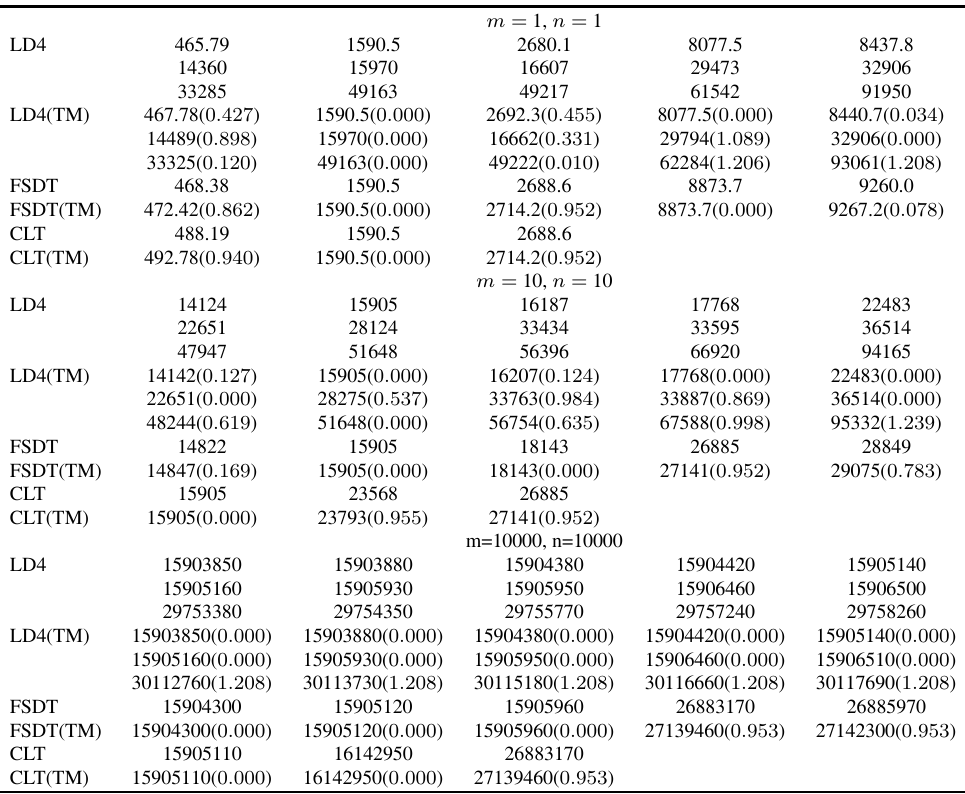
Table 8 Free vibrations of one-layered isotropic shell: higher-order frequency values f in Hz . Thickness ratio R α /h =